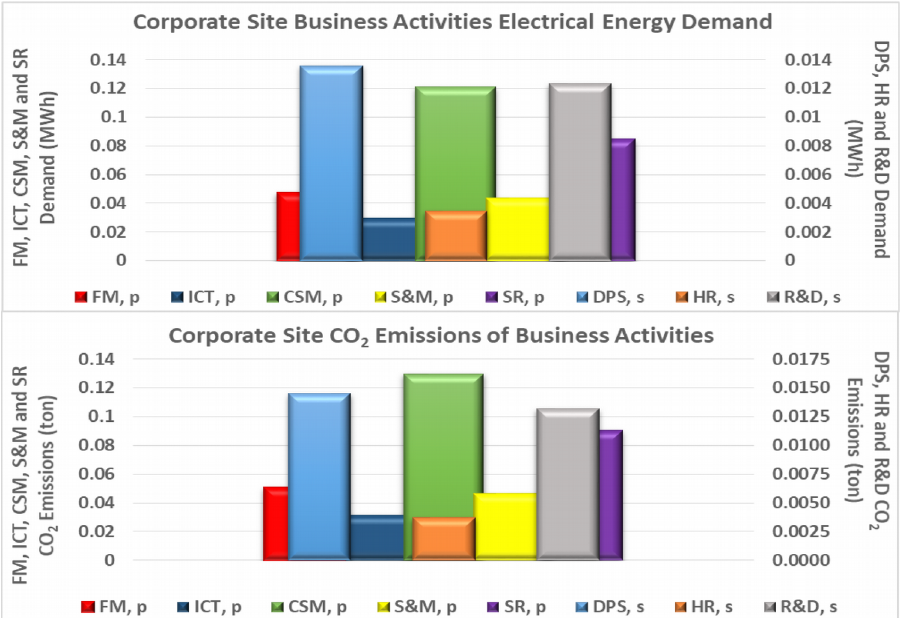
Figure 8. Electrical energy demand and CO